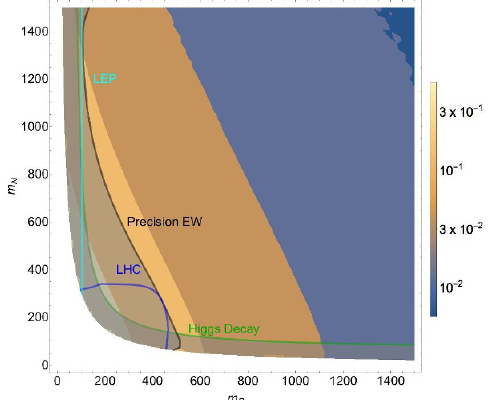
Figure 2 . Precision electroweak and collider constraints on the minimal vectorized lepton portal for (cid:21) = 1. The dark grey line shows the combined exclusion from precision electroweak tests, the cyan (LEP) and blue (LHC) indicate bounds from direct collider searches, and the green line shows the limit from the non-observation of invisible Higgs decays. The coloured contours indicate the shifts in the oblique (cid:1) T parameter due to the heavy